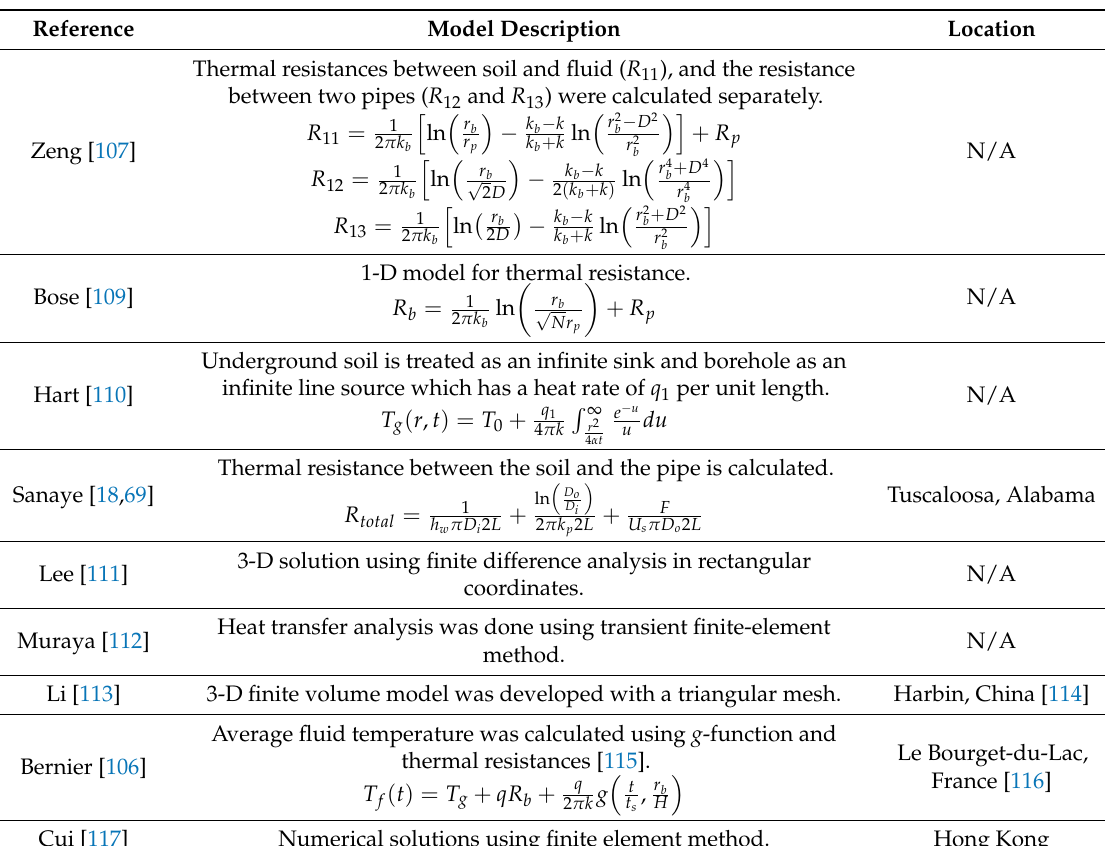
Table 2. Ground source water cooling